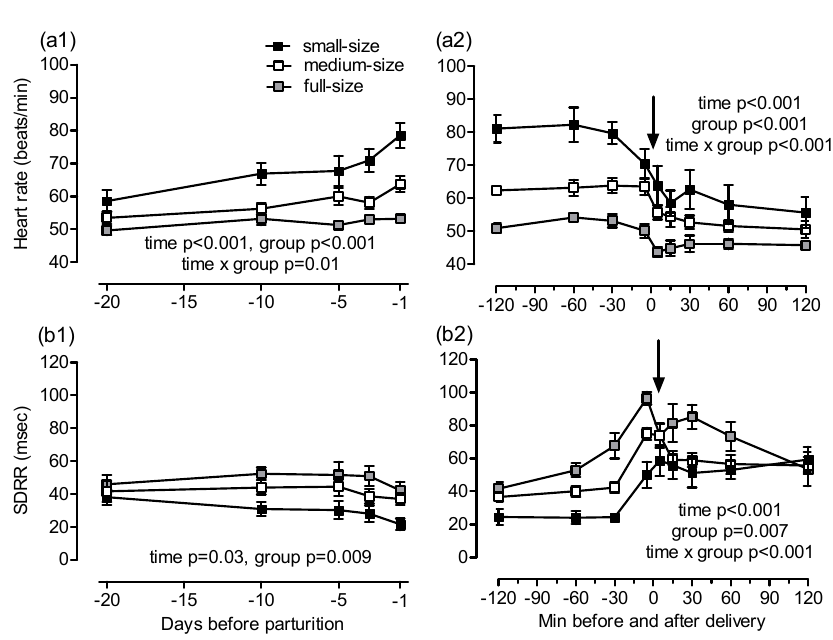
Figure 3. ( a ) heart rate and ( b ) SDRR (standard deviation of the beat-to-beat interval) in small (Shetland), medium-size (Haflinger) and full-size (Warmblood) mares ( 1 ) during the last 20 days before parturition and ( 2 ) in the same mares from 120 min before to 120 min after birth of the foal (arrow). Significant differences are indicated in the figures; for pairwise post-hoc comparisons, see text.